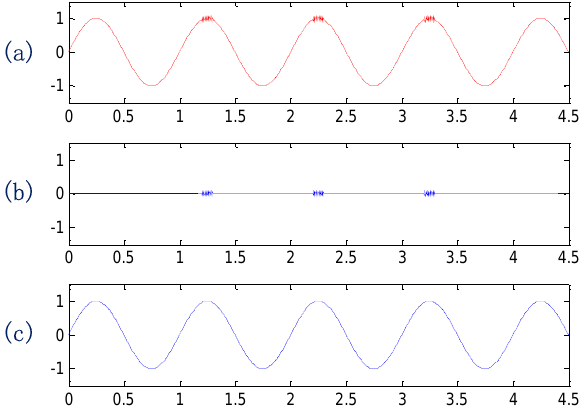
Figure 2. The simulation signal and its two components: ( a ) the simulation signal; ( b , c ) the two